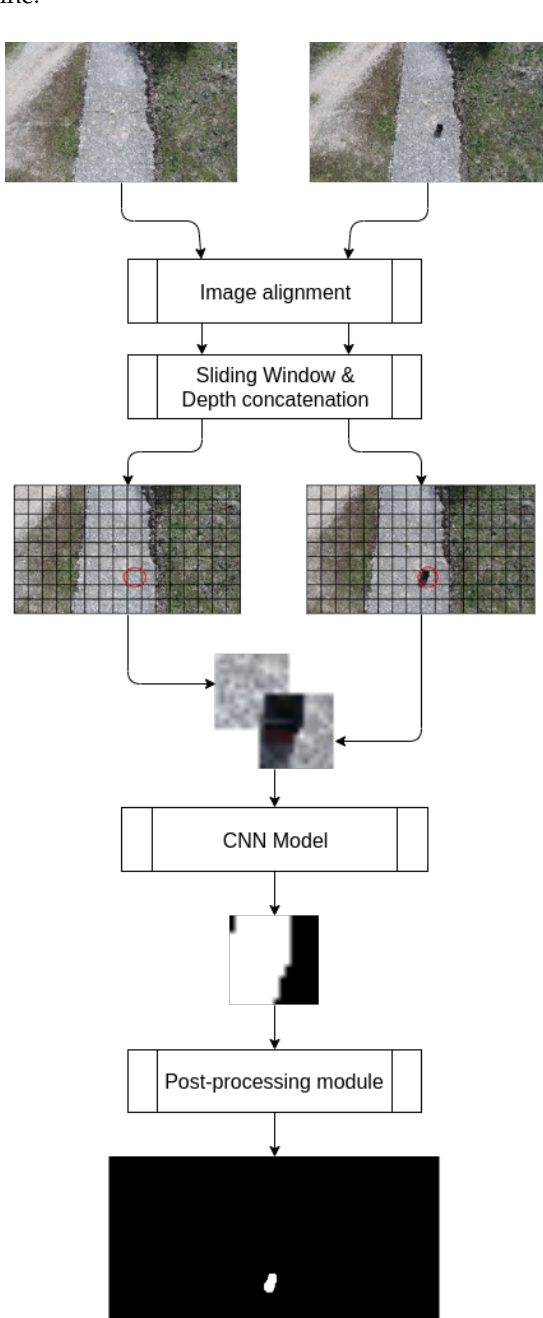
Figure 1. Block diagram of the system. Both reference and foreground images are introduced into our image alignment system. After that, sliding window algorithm is applied. The two resultant patches are concatenated along the depth axis. Ultimately, our CNN model predicts a grayscale image, which is post processed to obtain the final binary patch